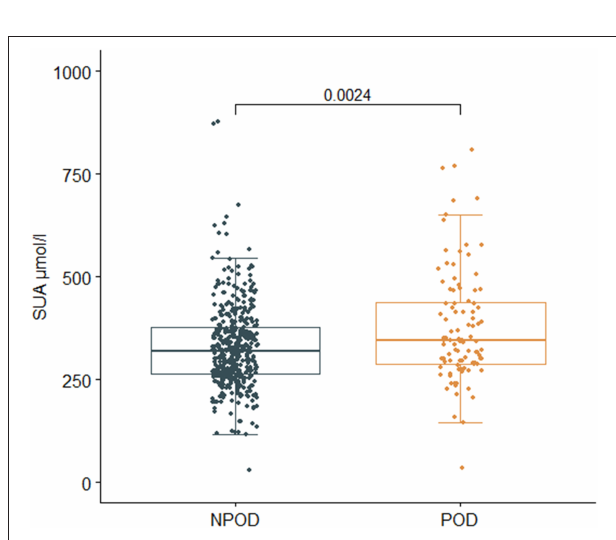
In addition, the incidence and severity of POD were higher in HS.